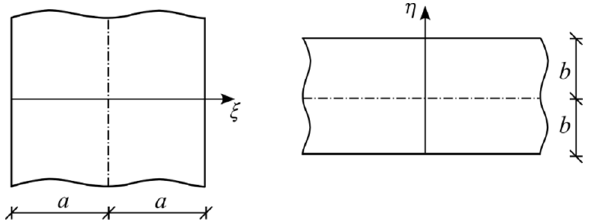
Figure 2. Crossed plate strips.